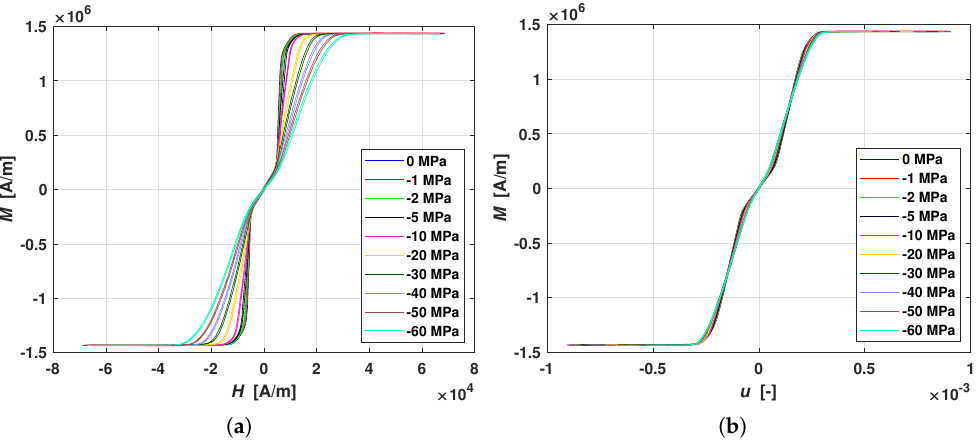
Figure 6. Magnetic characteristics ( M - H ) at different applied compressive stresses σ ( a ) and graphical representation of the self-similarity property ( b ) for SA Galfenol. It is possible to note how the M - u curves almost collapse into a single one, where u is defined as in Equation (16) with the parameters obtained from the minimization computation.